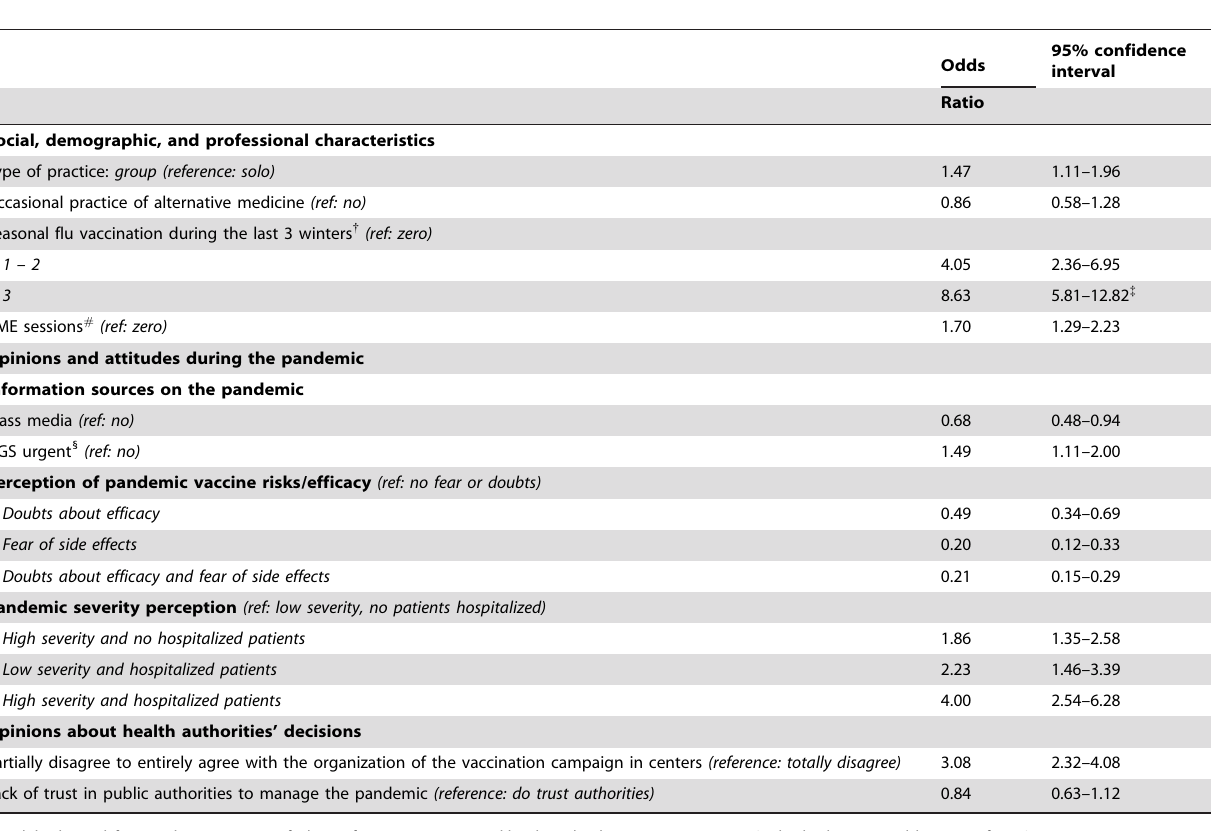
Table 3. Factors associated with personal vaccination of GPs against A/H1N1 flu (French nationwide panel of general practitioners, multi-model averaging, weighted data,